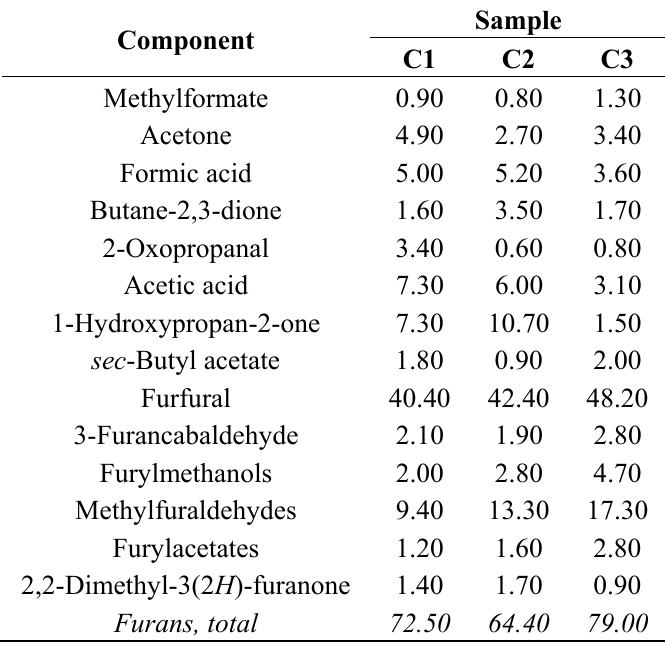
Table 3. Contents (mass%) of major compounds in the condensates obtained upon radiolysis of cellulose samples ( Z = 104 cm 2 /g)